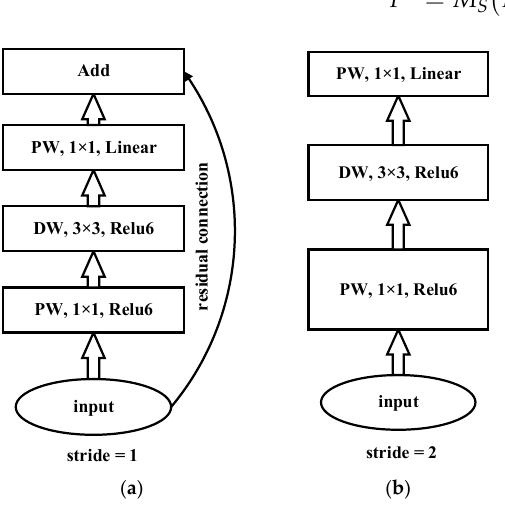
Figure 2. Depthwise separable convolution.